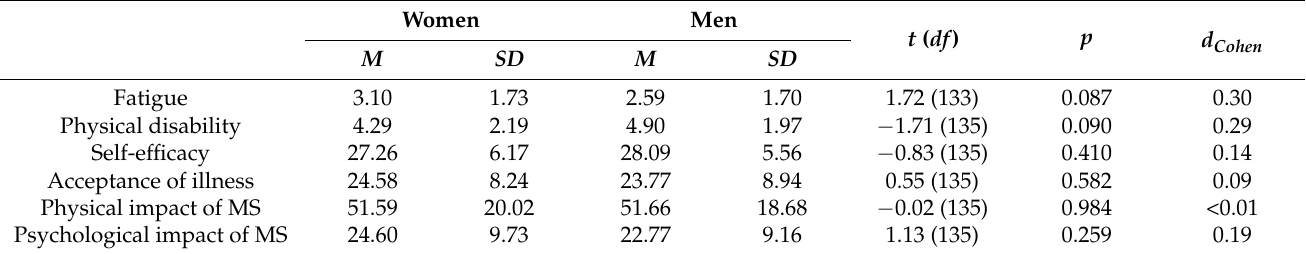
Table 2. Results of t -test comparisons.